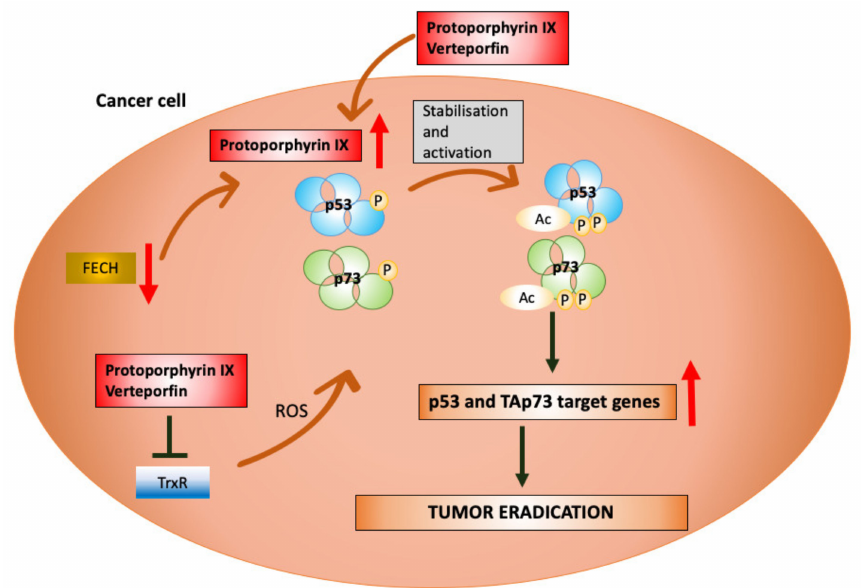
Figure 4. Repurposing porphyrins for improved cancer therapy. The low activity of ferrochelatase (FECH) in cancer cells leads to elevated levels of protoporphyrin IX (PpIX). High levels of PpIX sensitize malignant cells to exo-PpIX and Verteporfin, which bind to p53 and TAp73, stabilize the proteins, and induce p53- and TAp73-dependent transcriptional activity and apoptosis. Inhibition of thioredoxin reductase (TrxR) by PpIX and Verteporfin generates ROS and amplifies p53-dependent and TAp73-dependent apoptosis in cancer